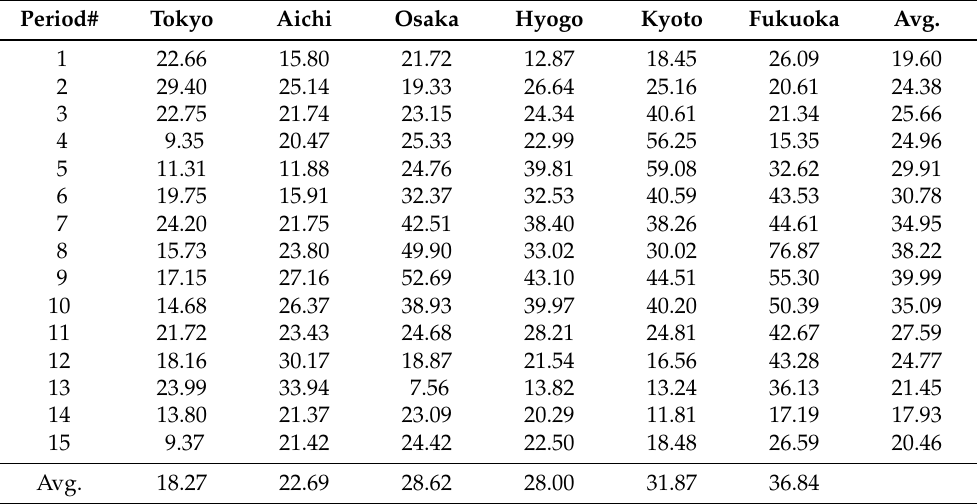
Table 3. Average absolute error [%] for DPC estimated in different regions and time